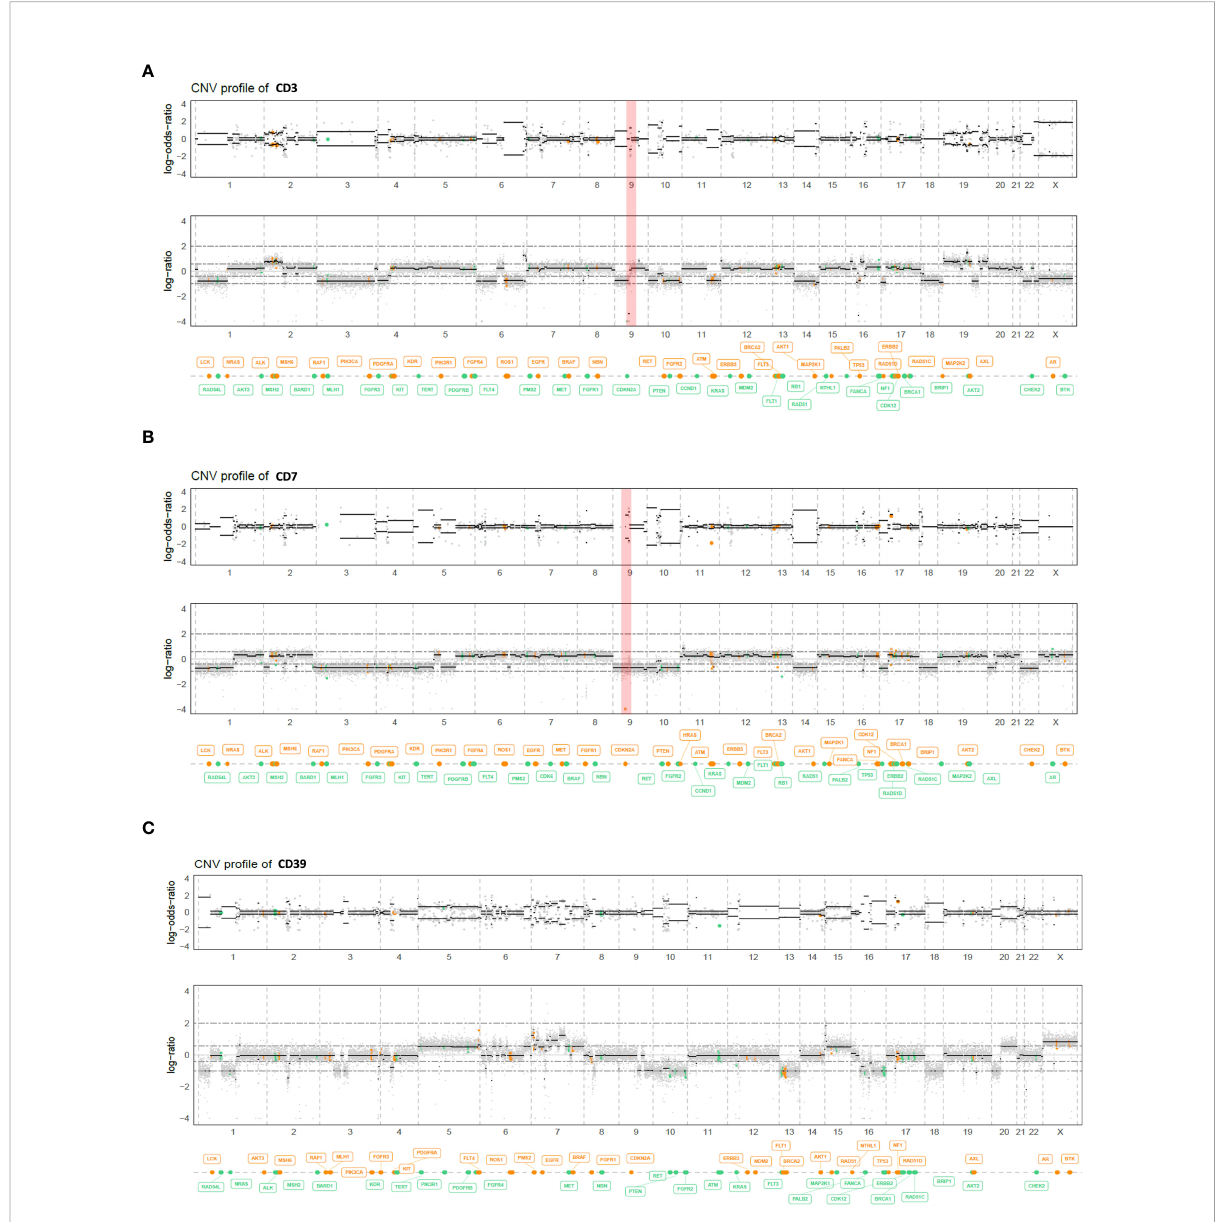
FIGURE 1 Genome view pro fi les of the allele-speci fi c copy number of the CD3 (A) , CD7 (B) , and CD39 (C) chordoma PDX models. The top graph log- odds-ratio represents the B-Allele Frequency (BAF), and the bottom graph the log depth ratio between tumor and a healthy witness. Both CD3 and CD7 chordoma PDX models harbored a homozygous deletion of CDKN2A/2B (red bar), whereas CD39 did